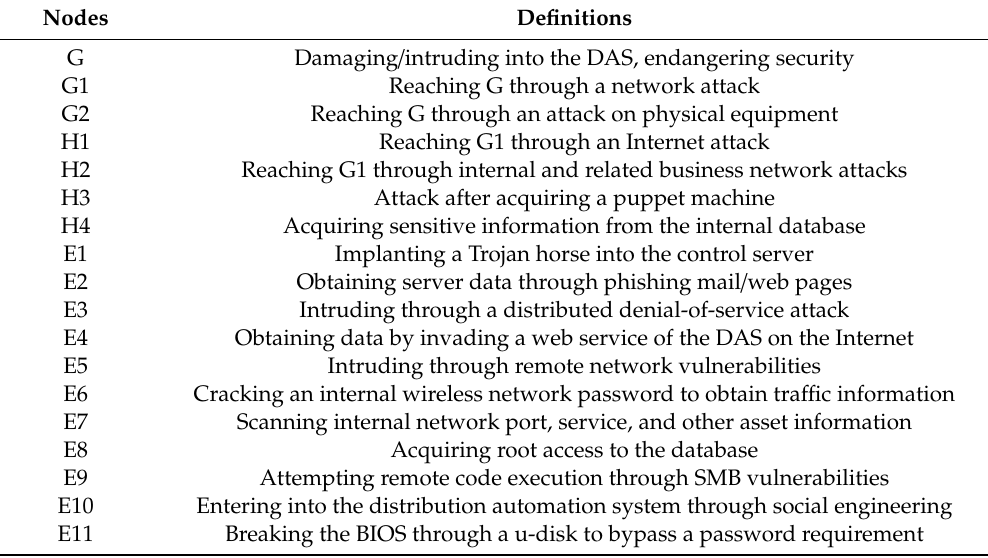
Figure 6. The DAS AT and attack path. Table 2. Definitions for all nodes in the DAS AT.